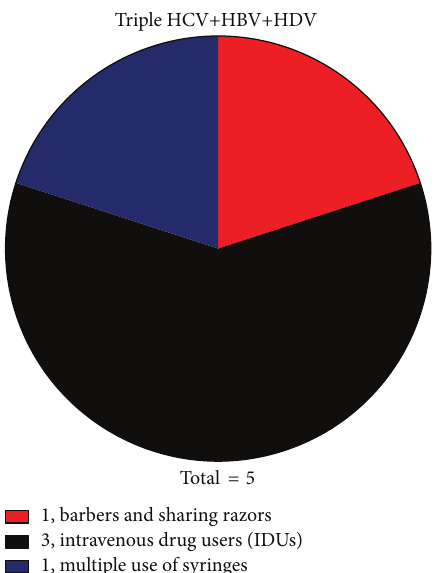
Figure 8: Risk factors associated with HCV, HBV, and HDV triple